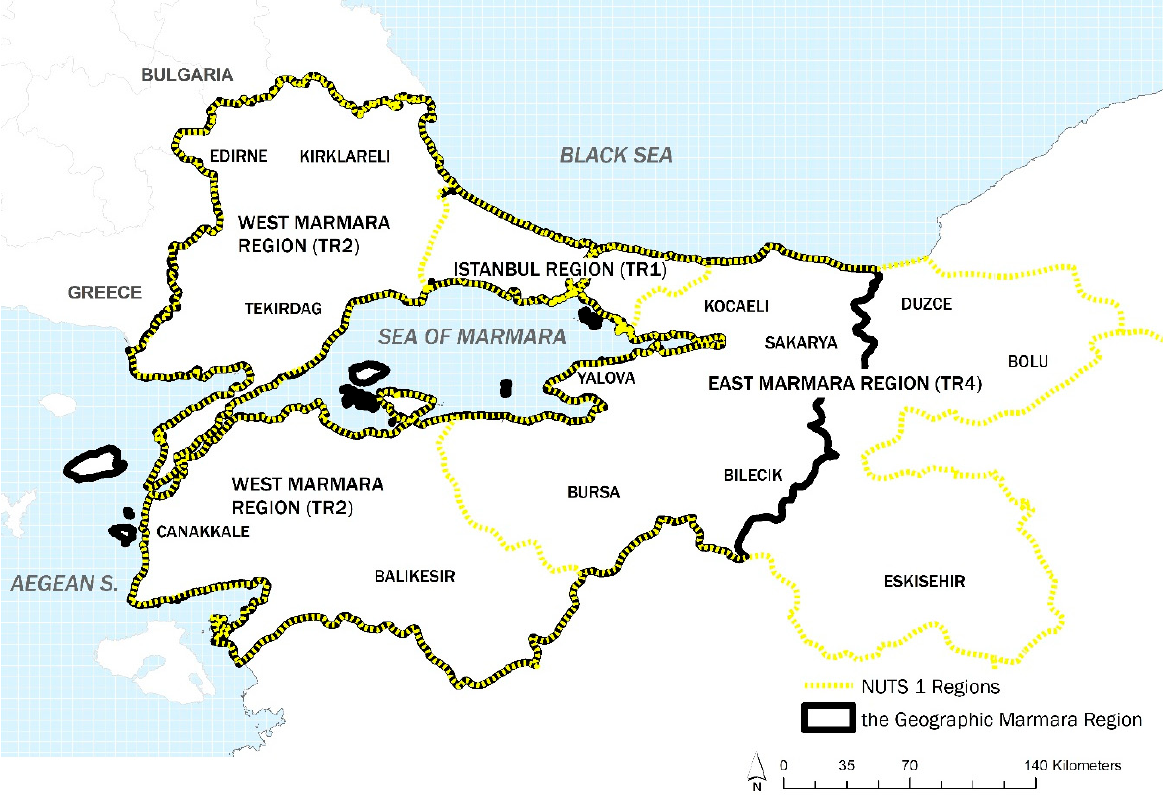
Figure 6. NUTS 1 regions (marked in yellow) overlaid onto the geographic Marmara Region (marked in black).